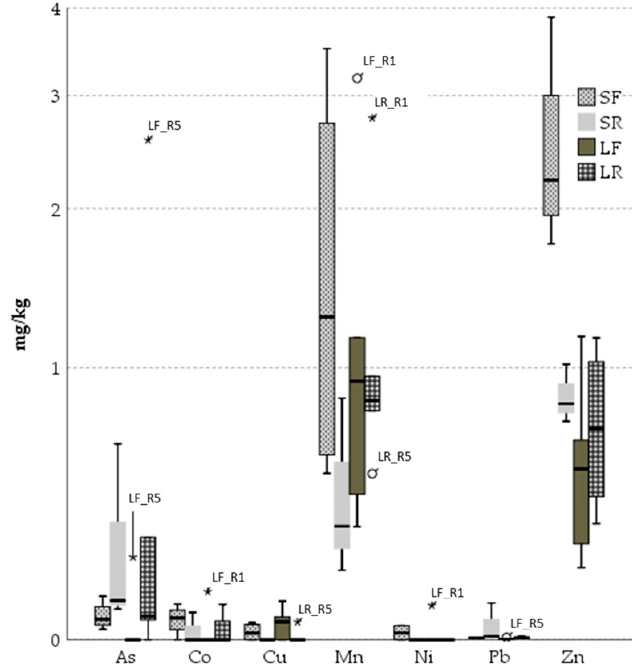
Figure 14. Variation of the PTE concentrations in the plant roots and flowers from the most and least contaminated points (R1, R2, R4, R5, R8 and R16) at the mining areas of Regoufe. SF— S. anglicum Huds. flowers, SR— S. anglicum Huds. roots, LF— Lolium sp. flowers, LR— Lolium sp. roots. Circles and asterisks correspond to outlier concentrations identified as plant species organ_sampling site.